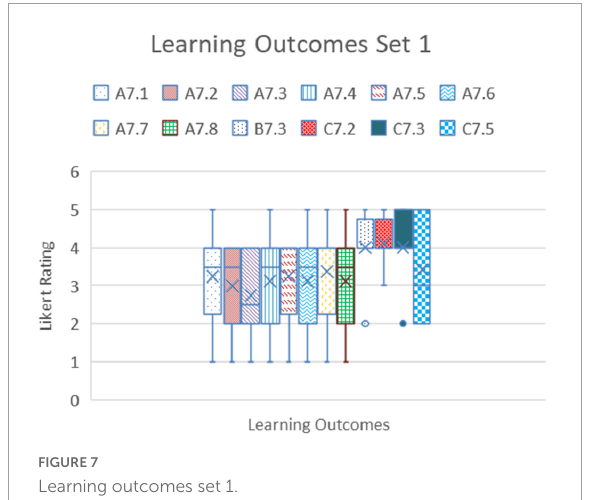
FIGURE7 Learning outcomes set 1.